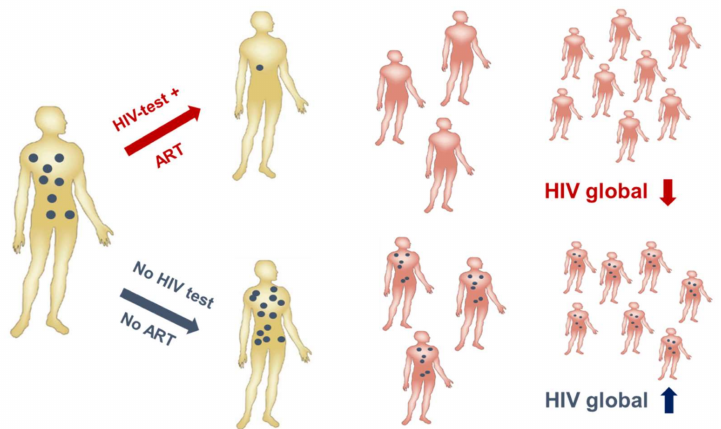
Figure 3. Human immunodeficiency virus (HIV) testing is essential to contain the HIV epidemic. A positive HIV test (upper panel) will be followed by the initiation of anti-retroviral treatment (ART) leading to reduced viremia (blue). Consequently, virus transmission is reduced/inefficient resulting in a global drop of HIV burden. Undiagnosed HIV infections will not be treated (lower panel) resulting in transmissions and a global rise in HIV infections. (Modified from Dietrich,